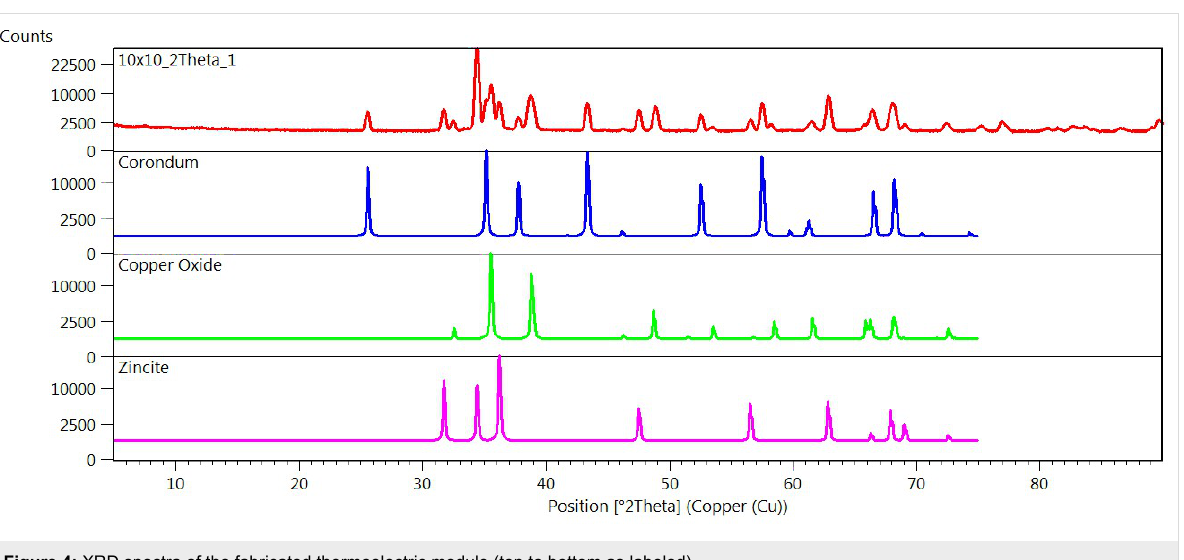
Figure 4: XRD spectra of the fabricated thermoelectric module (top to bottom as